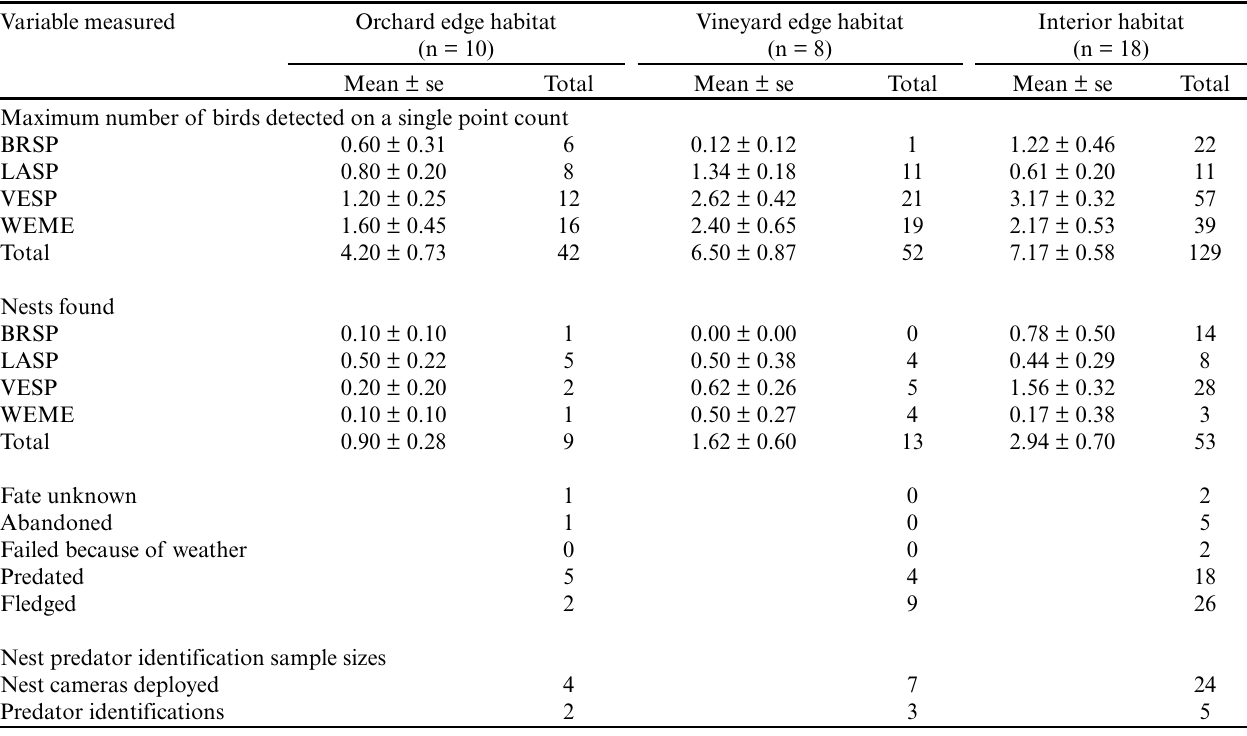
Table 5 . Numbers of songbirds detected, songbird nests found (including fate), and nest predator identifications in three types of sagebrush habitat. Songbird species studied were Brewer’s Sparrows, Spizella breweri (BRSP), Lark Sparrows, Chondestes grammacus (LASP), Vesper Sparrows, Pooecetes gramineus (VESP), and Western Meadowlarks, Sturnella neglecta (WEME). Variable